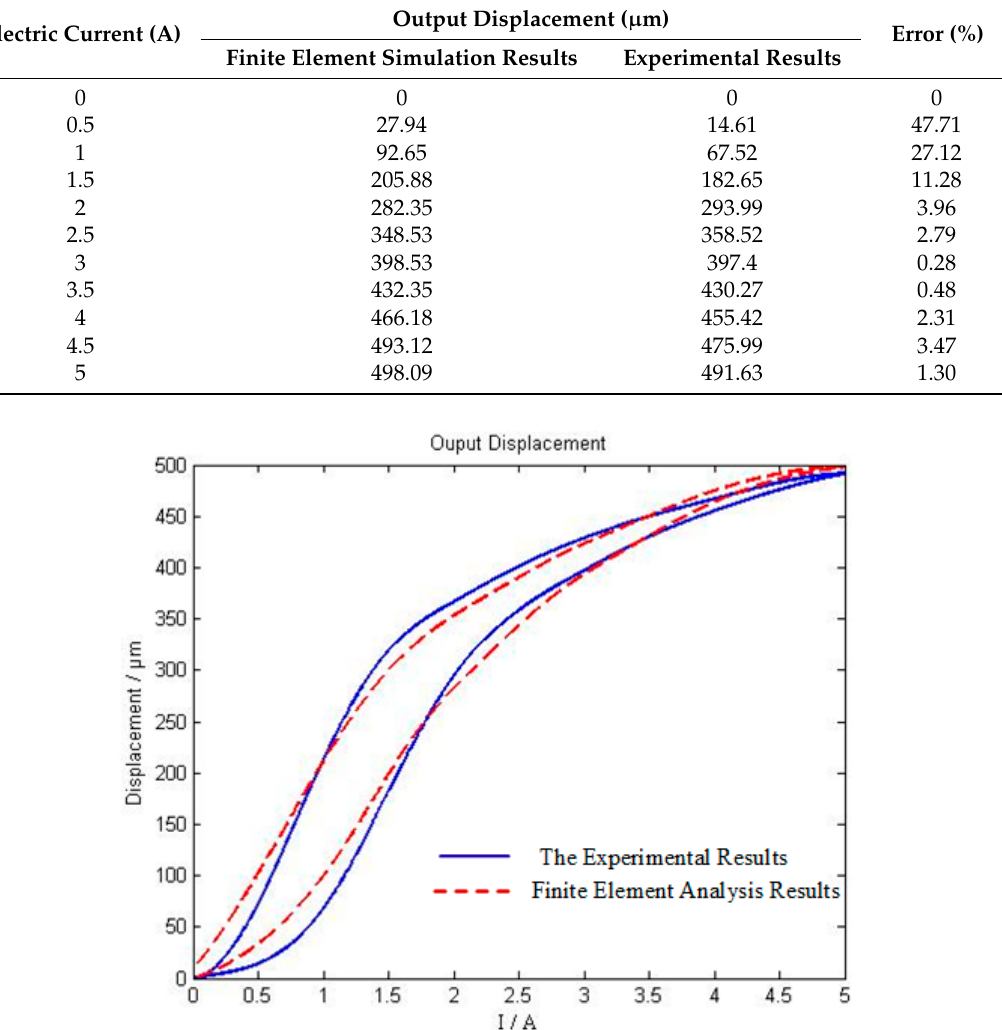
Table 1. Comparison between the finite element model analysis and experimental results.